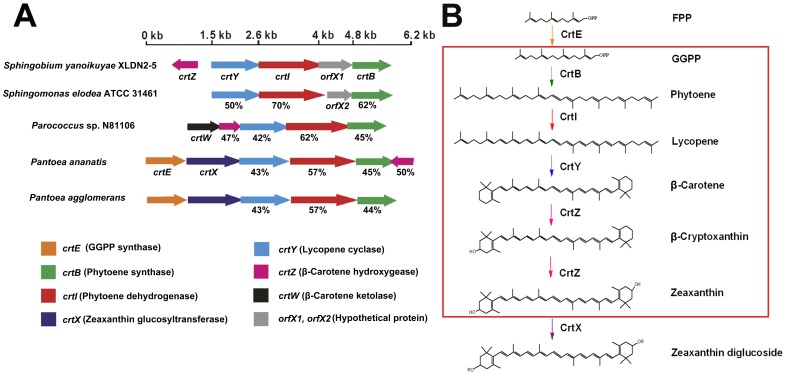
Carotenoid biosynthetic pathway and the genes involved in the biosynthesis of zeaxanthin in Sphingobium yanoikuyae XLDN2-5.(A) Genetic organization of the crt genes in strain XLDN2-5 compared to similar gene clusters from other bacteria. (B) The proposed carotenoid biosynthetic pathway in strain XLDN2-5 is inside the red box. CrtE: GGPP synthase (orange); CrtB: Phytoene synthase (green); CrtI: Phytoene dehydrogenase (red); CrtY: Lycopene cyclase (blue); CrtZ: β-Carotene hydroxygenase (magenta); CrtW: β-Carotene ketolase (black); CrtX: Zeaxanthin glucosyltransferase (purple); orfX1 and orfX2: No predicted function (grey). The percent of numbers represents the amino acid (aa) identities of related enzymes.